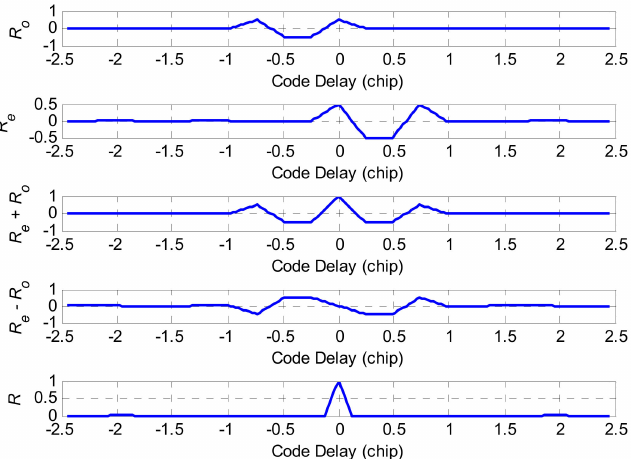
Figure 8. The reconstruction correlation function of the BOCc(1,1) signal.